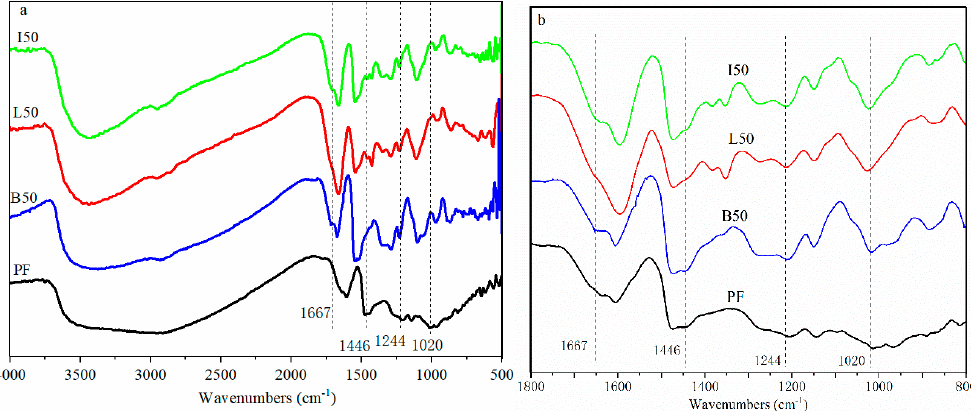
Figure 5. ( a ) FT-IR spectra of PF, ALPF (L50), and DLPF (I50, B50) resins with 50% lignin substitution; ( b ) enlarged spectral region shows signals of particular